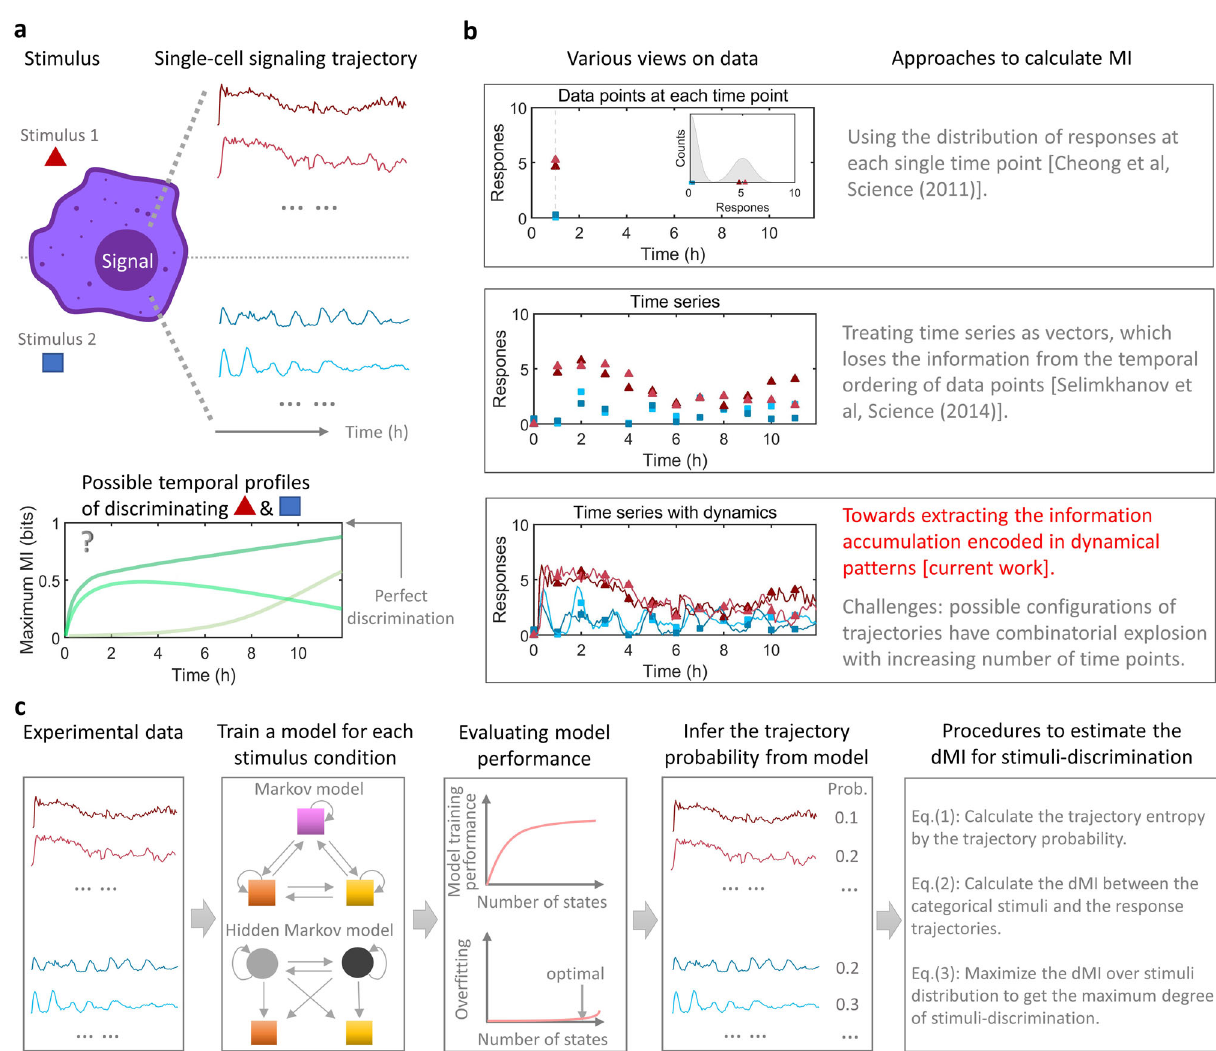
Fig. 1 Toward quantifying information accumulation encoded in the dynamics of biochemical signaling molecules. a (Upper) When cells encounter a stimulus, the responses of a major signaling molecule transmit information to the nucleus so that cells respond appropriately. The temporal trajectories of single-cell signaling response can have rich dynamics, such as the two exempli fi ed trajectories under each separately added stimulus. (Lower) The maximum mutual information (MI) between the responses and the stimulus conditions quanti fi es the number of conditions that can be effectively distinguished. If the information is perfectly transmitted, it would reach log 2 ð M Þ bits for M distinct stimulus conditions. The information transmits over time, and the temporal pro fi le of cells acquiring the information for stimuli-discrimination remains to be explored. b An overview of the three representative approaches of quantifying the mutual information. c The work fl ow of the present approach. The measured trajectory ensemble under each stimulus condition can be learned by training a time-inhomogeneous Markov model or a hidden Markov model (circles are hidden states and squares are emission states in the model schematic). Under the optimal number of states, such stochastic models enable to infer the trajectory probabilities and develop the dynamical mutual information (dMI), which quanti fi es the mutual information encoded in signaling dynamics